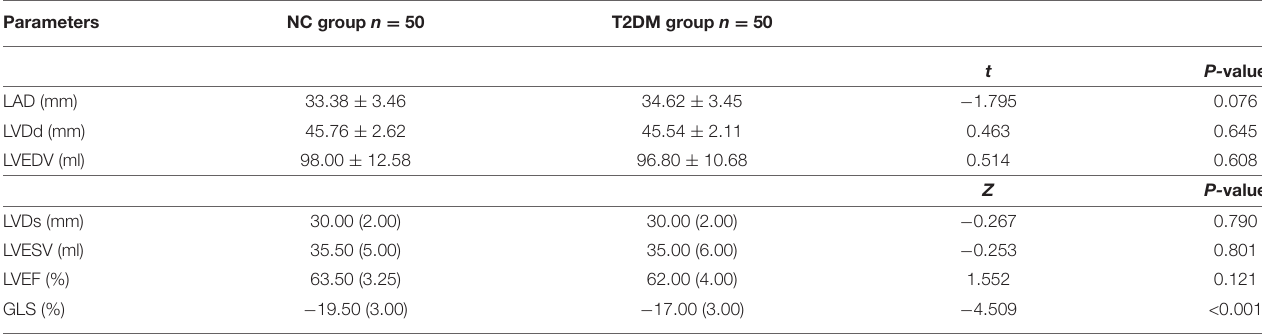
TABLE 2 | Statistical comparisons of conventional echocardiographic parameters and GLS between NC and T2DM groups.